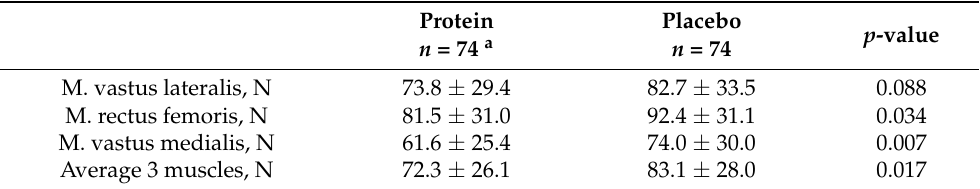
Table 4. Pressure pain thresholds with a strain gauge algometer measured 1–2 days post-race, based on ITT.